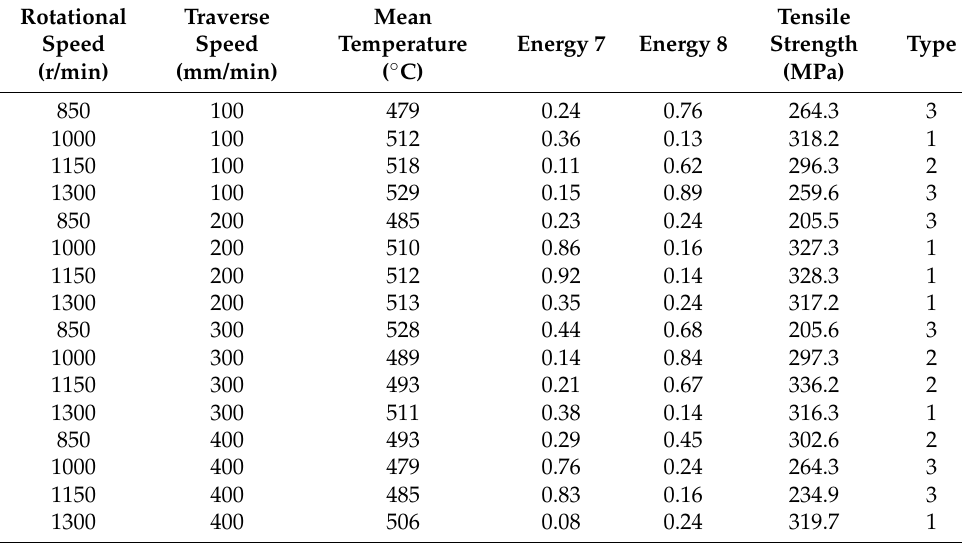
Table 3. Test data of partial